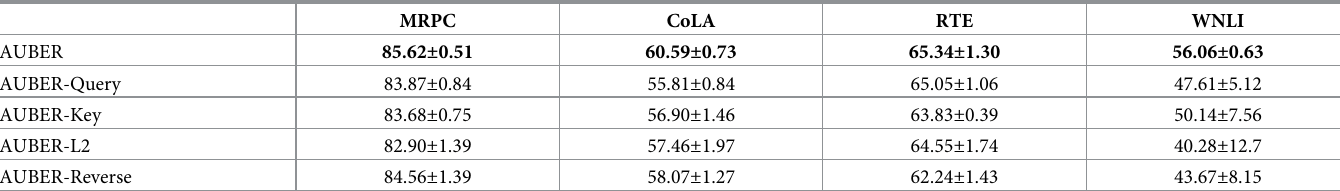
Table 3. Performance of AUBER and its variants. Comparison of AUBER with four variants: AUBER-Query, AUBER-Key, AUBER-L2, and AUBER-Reverse on four GLUE datasets to demonstrate the effectiveness of various ways to calculate the initial state. AUBER-Query and AUBER-Key use the query and key matrices respectively, and AUBER-L2 uses the L2 norm of the value matrix to obtain the initial state. AUBER-Reverse processes BERT starting from the final layer (e.g. 12 th layer for BERT- base). Bold font indicates the best performance among pruning